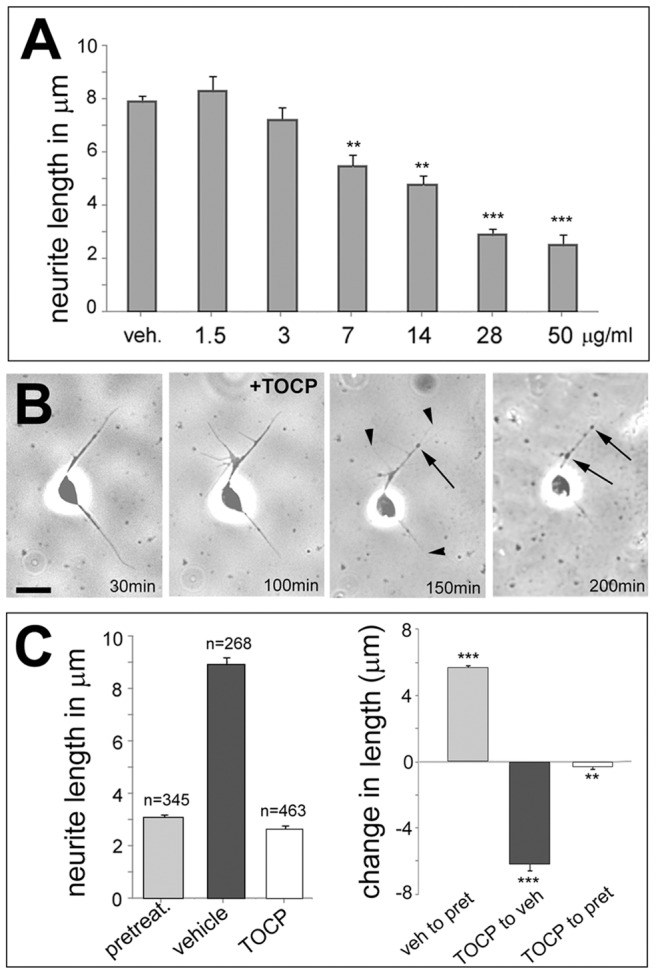
TOCP induces neurite shortening in primary neuronal cultures.
A. Dose response curve showing that TOCP doses equal or higher than 7 µg/ml cause a significant reduction in neurite length. 30–56 neurons were measured for each condition. B. Live imaging of a neuron treated with 14 µg/ml TOCP reveals the formation of varicosities (arrows) and neurite degeneration (arrowheads) 50 min after the addition of TOCP. Another 50 mins later, these phenotypes are even more pronounced. C. The length of neurites is dramatically reduced in TOCP treated cells versus mock treated cells, but also significantly shorter in TOCP treated cells compared to cells that have been fixed at the time of treatment (left graph). The graph on the right shows the change in length between each condition. Analysis was done using one-way ANOVA with a Dunett's post test to compare to mock treated cells. n = number of cells measured and the SEMs are shown. **p<0.01, ***p<0.001. Scale bar in B = 2 µm. (The variances were significantly different between treated and untreated cells; p<0.001).